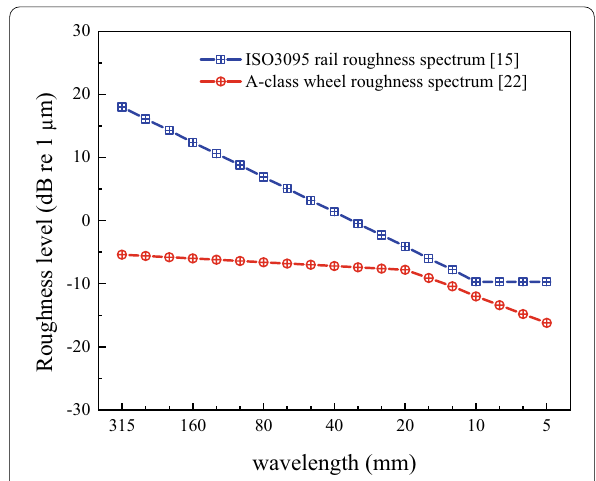
Figure 8 Wheel-rail noise prediction model and validation